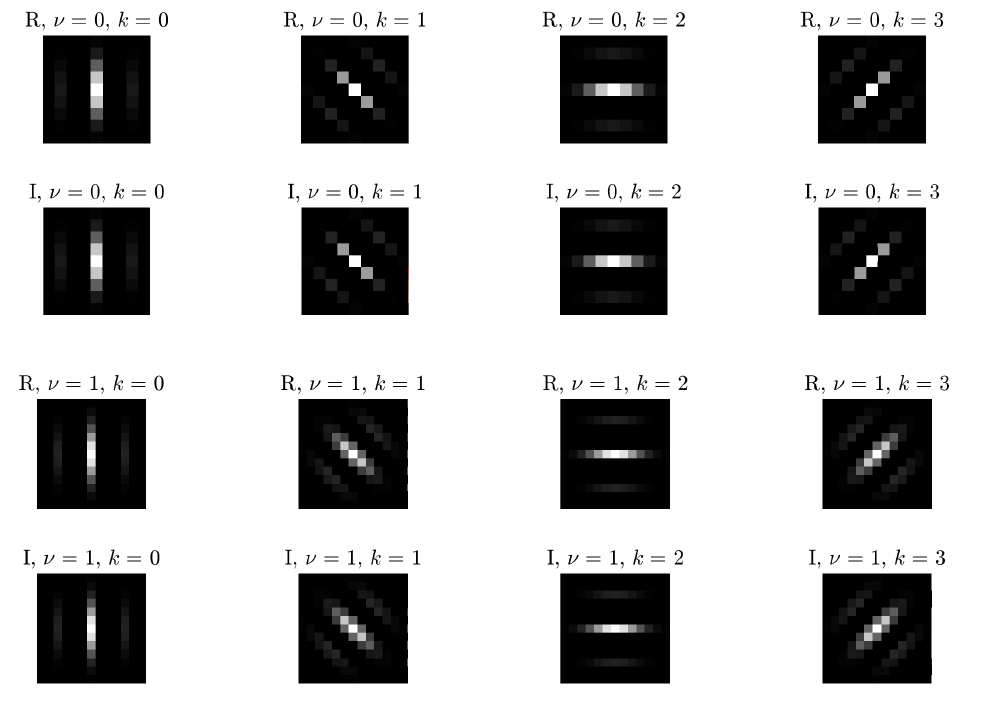
Figure 2. Examples of 16 real-valued Gabor filters defined by Equation (1) corresponding to the parameters values ν